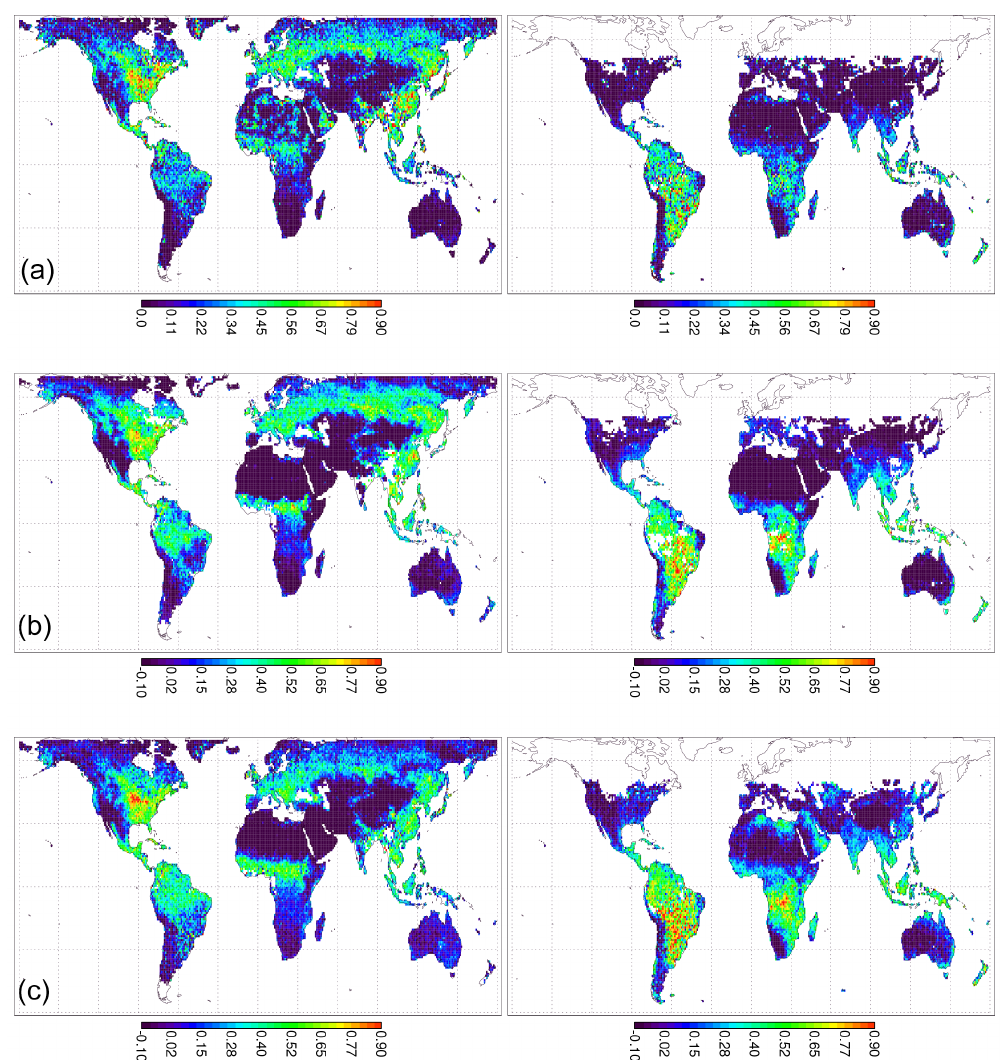
◦ cell boxes with zero-level adjustment. (a) SCIA-